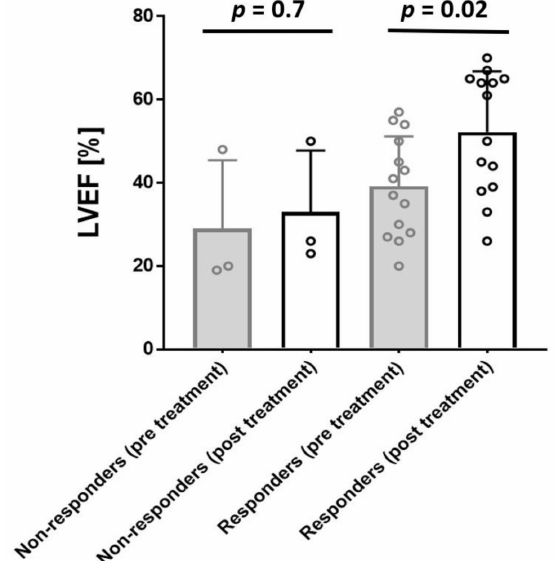
Figure 3. LVEF of non-responders and responders pre- and post-treatment. Bar height indicates LVEF (%) in non-responders’ ( n = 3) and responders’ ( n = 14) group pre (baseline) and post (follow-up) LTD-treatment. Dots indicate individual values. LVEF improvement was significantly improved in patients who reduced or lost the replicative viral intermediates (positive B19V RNA). LVEF is given as mean value and error bars represent